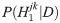
Posterior distribution of veering probability.Figure shows the computed probability distribution p(θ|D, B1jk) of the reference bird ‘Four’ veering to the right when encountering ‘Milkyway’. The red dashed line indicates the mean of the posterior distribution, i.e. the predicted probability P(H1jk|D).